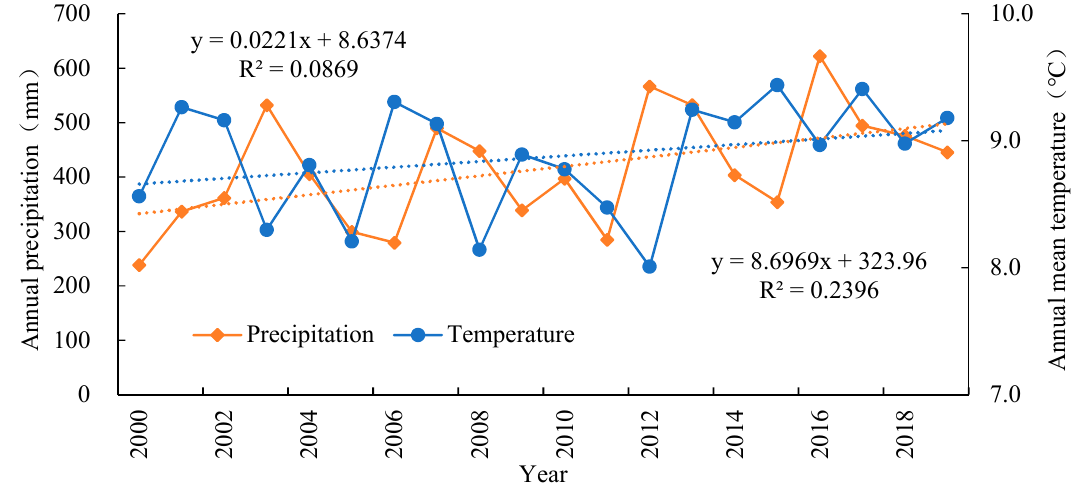
Figure 16. Variations in precipitation and temperature from 2000 to 2019.